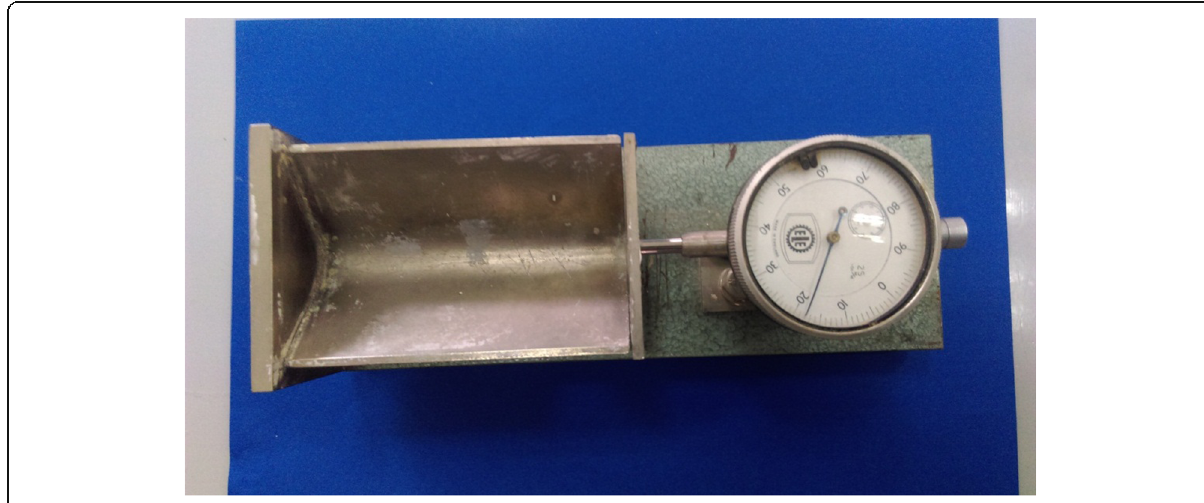
Fig. 3 Extensometer device with micrometric clock